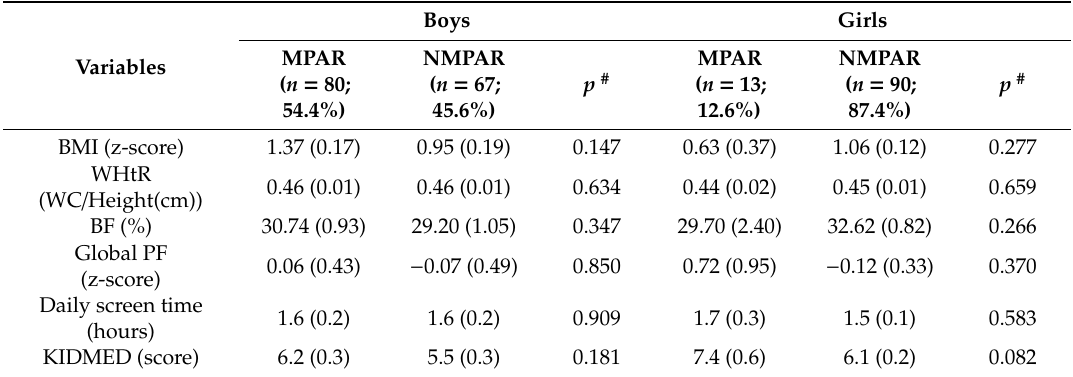
Table 2. Mean di ff erences of obesity-related parameters, global physical fitness score, screen time hours, and KIDMED score, according to the meeting of physical activity recommendations and